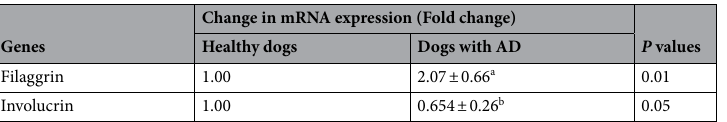
Table 2. Relative mRNA expression of Filaggrin and Involucrin in the lesional skin of dogs with AD and healthy controls. Data presented are Mean ± SD. a Significantly higher when compared with healthy control. b Significantly lower when compared with healthy control.